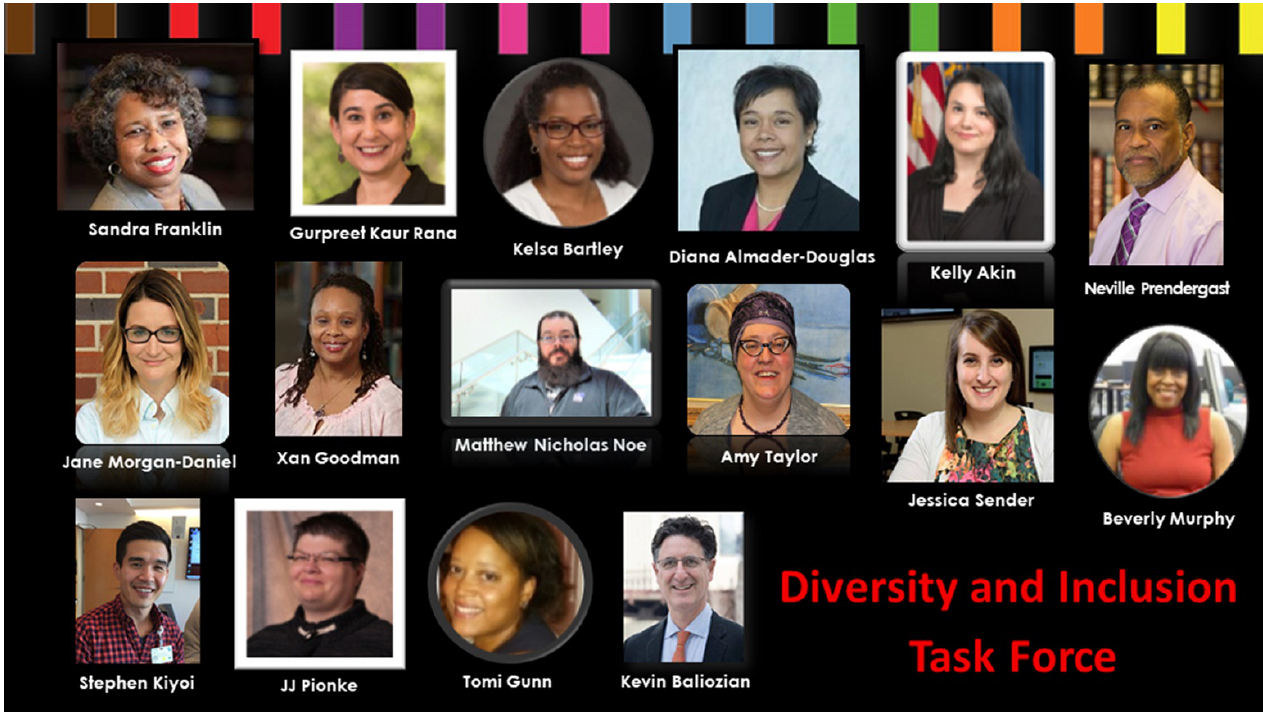
Figure 1 Diversity and Inclusion Task Force (DITF) members shown in a PowerPoint slide by Beverly Murphy, AHIP,